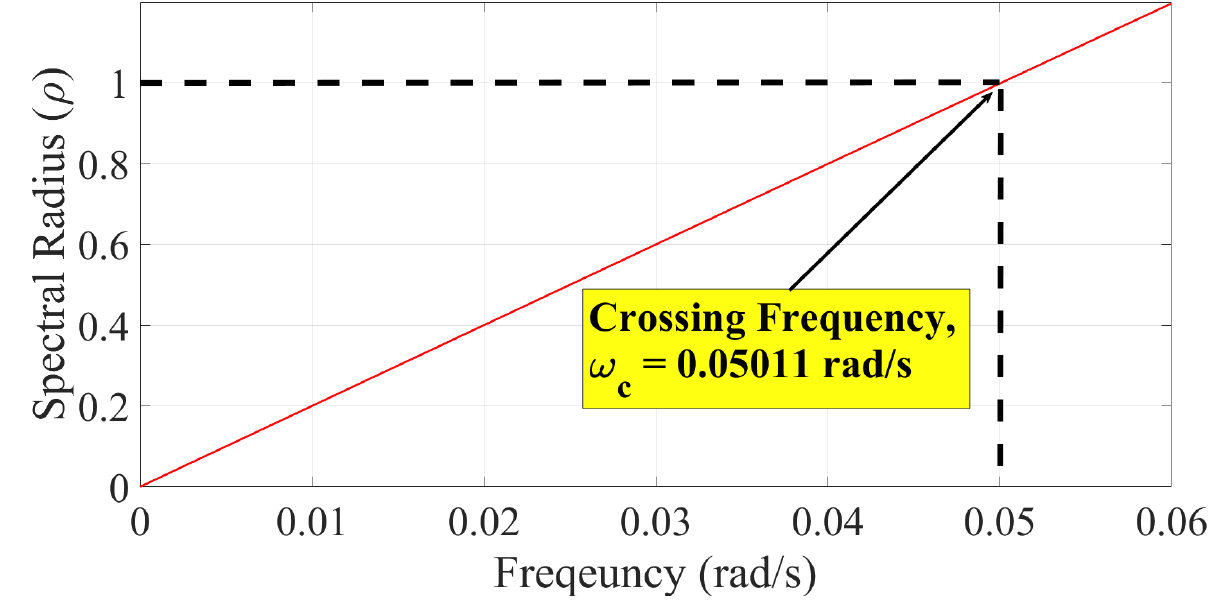
Figure 18. The spectral radius, ρ , against the frequency, ω , for K P = 0.05 and K I = 0.05. Four other published methods were compared with the proposed method. As indi- cated in [28,29], the DM method produces less traditional results than the LMI method, but the LMI method has the advantage of handling delays that fluctuate over time. The proposed method is easier to execute, yet the DM results are similar to those obtained using the frequency domain techniques, as described in